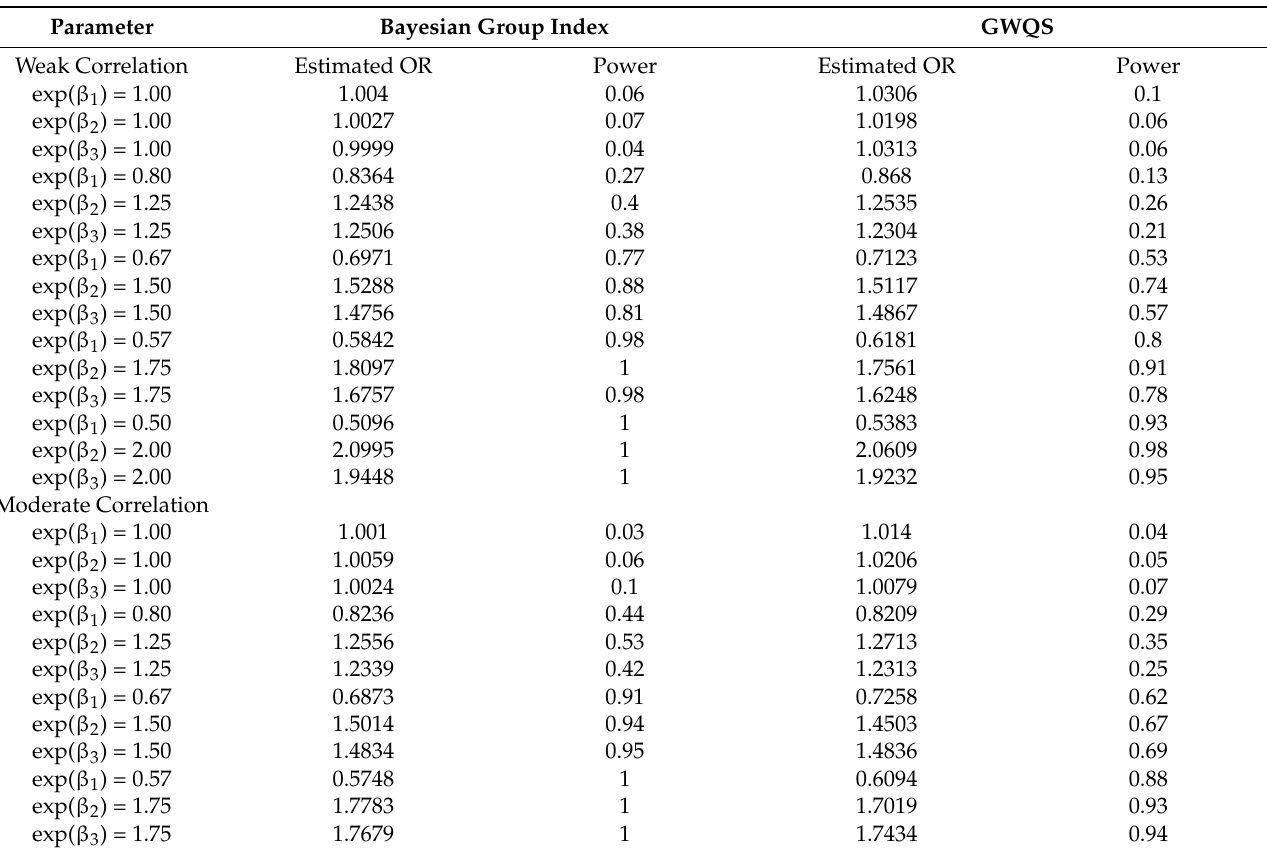
Table 2. Estimated odds ratio (OR) and power values for the Bayesian group index model and group weighted quantile sum (GWQS) regression for Scenario